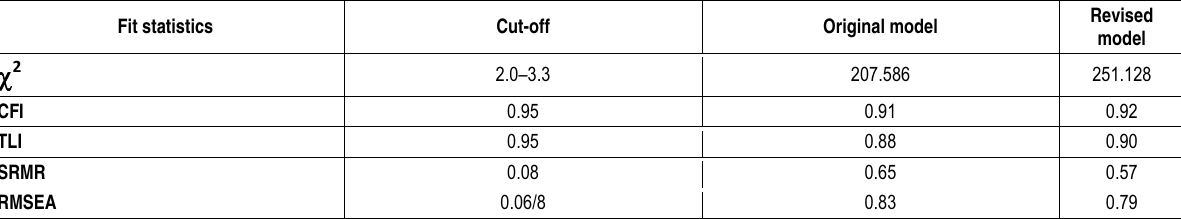
Table 3. Fit indices of environmental determinants on job